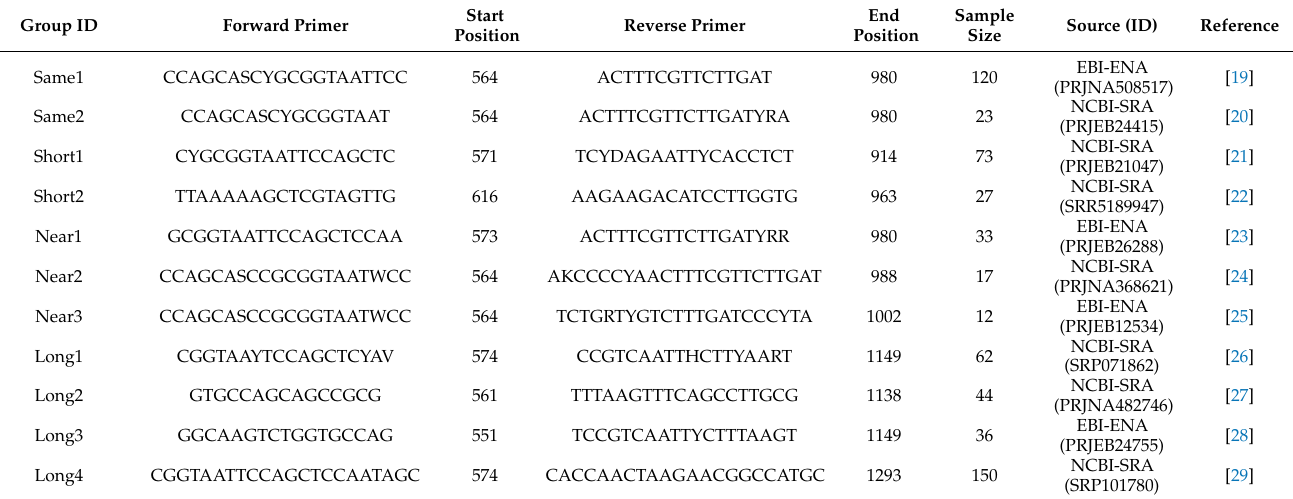
Table 1. Data and primers